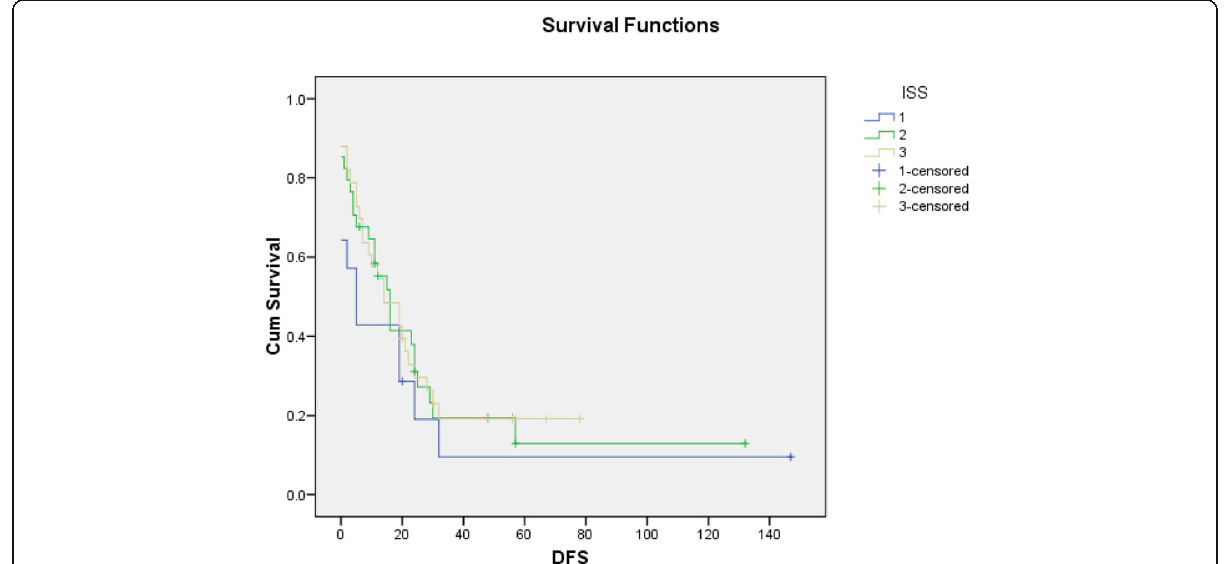
Fig. 1 Kaplan-Meier analysis for DFS between the different ISS stages